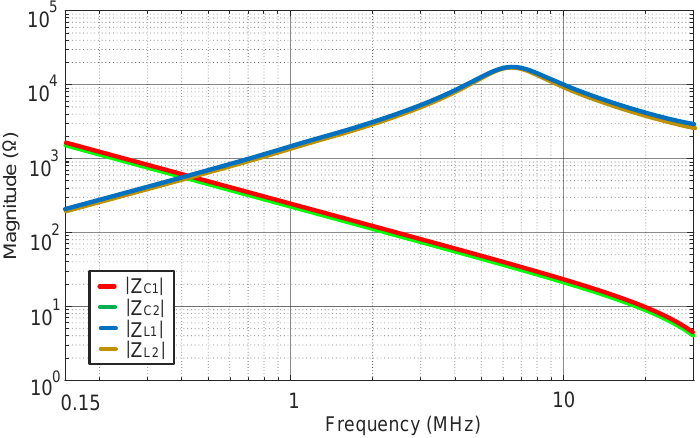
Figure 10. Magnitude comparison of bridge arms impedance (Z C1 VS. Z C2 and Z L1 VS. Z L2 ).